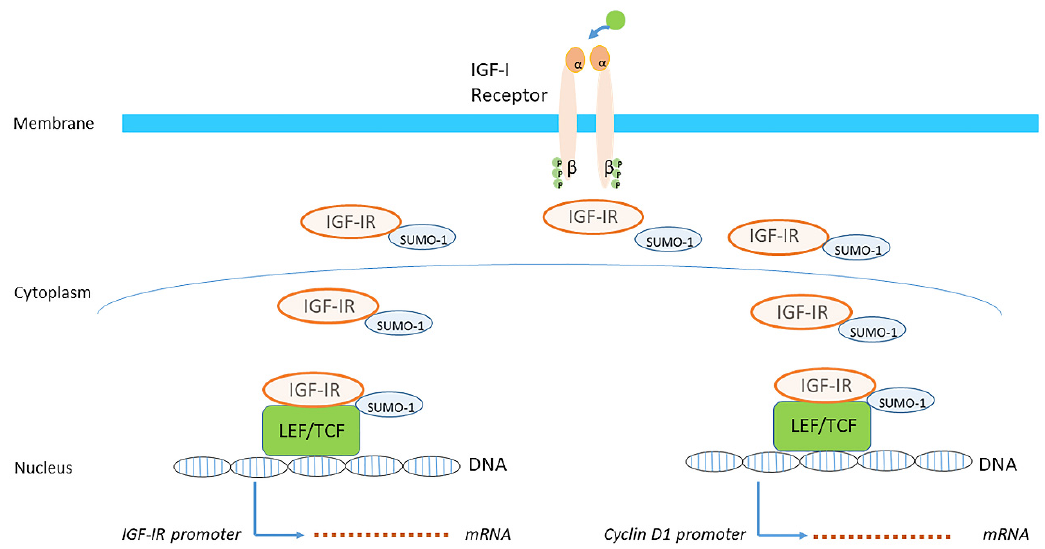
Figure 6. Studies have confirmed that ligand-mediated phosphorylation of the IGF-IR is essential for nuclear tra ffi cking. Following binding of IGF-I to the IGF-IR at the cell surface, the IGF-IR is transported into the cell and further translocated from the cytoplasm into the nucleus. SUMOylation (SUMO-1) in the cytoplasm of the IGF-IR also plays a crucial role in the nuclear translocation of the IGF-IR from the cytoplasm. When the SUMOylated IGF-IR translocates to the nucleus, it is thought to be involved in the transcriptional enhancement of specific target genes. Nuclear IGF-IR is able to autoregulate expression of its own gene leading to an increase in IGF-IR promoter activity and IGF-IR expression (left). Nuclear IGF-IR may also bind to Cyclin D1 (and additional) promoters with ensuing target gene activation (right). (Modified from Sarfstein & Werner. Minireview: nuclear insulin and insulin-like growth factor-1 receptors: a novel paradigm in signal transduction. Endocrinology, 2013;